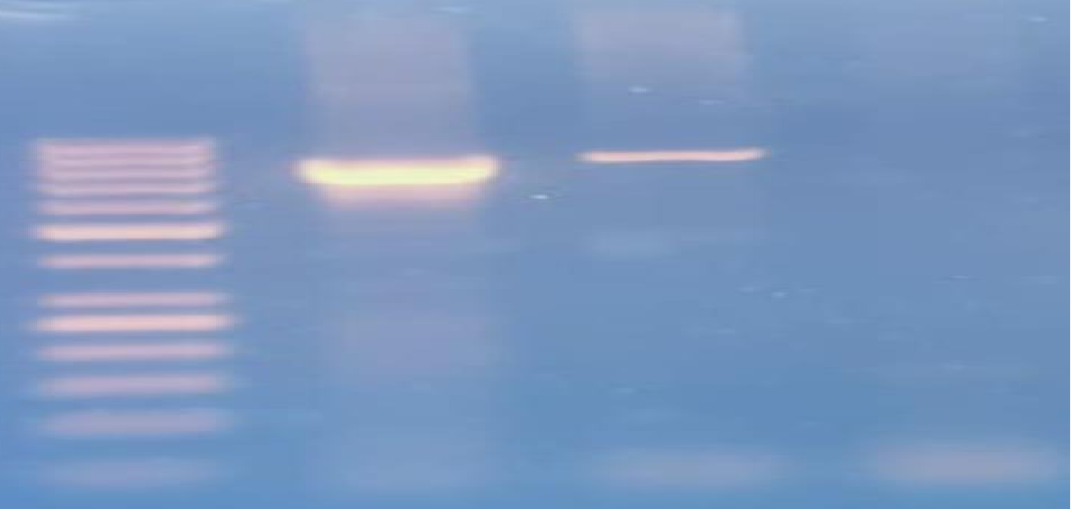
Figure 2. Shows gel electrophoresis of Acinetobacter baumannii 16S rRNA. Lane 1 shows positive control and tested Acineto at Lane 2 at 600